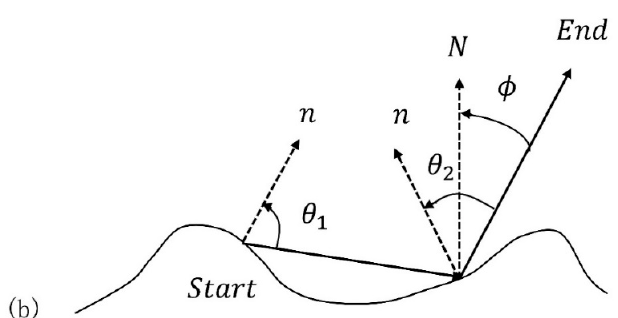
Figure 2. Sketch showing the reverse approach used to calculate the geometry of an individual ray path for emitted photons exiting the surface at an angle φ relative to the average surface. In ( a ), the motion is downward from the ‘Start’ along a ray path defined by the angle φ . Specular reflection is assumed when the ray strikes another facet on the surface. Motion ceases when the ray leaves the surface or reaches a predetermined maximum number of reflections. The emission is computed by reversing the direction of the ray path, using the point of the last reflection (‘Start’ in ( b )) as the initial source of radiation along the ray. (Modified from Henderson et al. [17]).